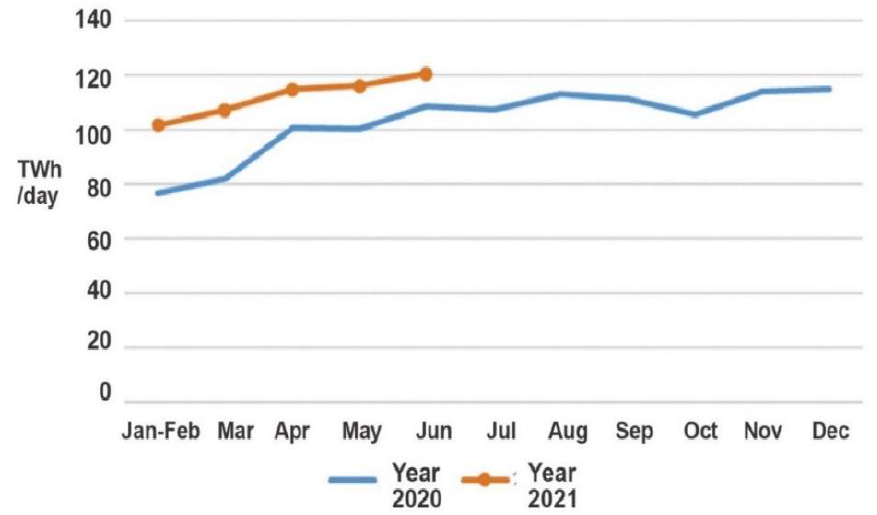
Figure 18. Electricity Consumption by the industrial and manufacturing sectors in 2020–2021 [75]. Source: CEC (2021) Statistics of Electricity Consumption. All rights